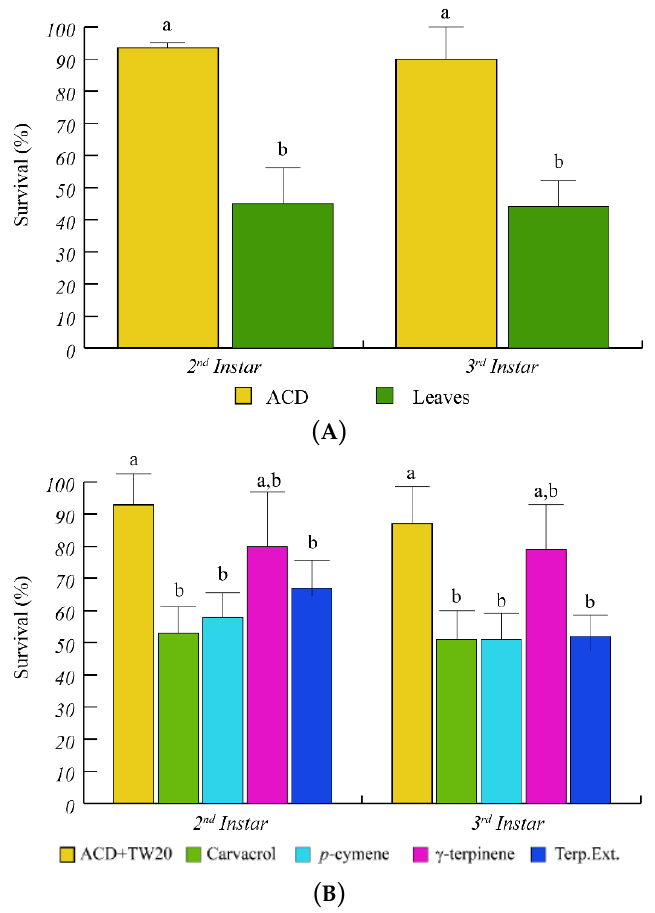
Figure 2. Percentage of S. littoralis survival upon feeding on O. vulgare leaves and terpenoids. ( A ) Comparison of S. littoralis survival upon feeding on artificial diet (ACD) or O. vulgare leaves. ( B ) Effect of terpenes extracted from O. vulgare leaves and of some O. vulgare monoterpenes on S. littoralis survival. ACD + Tween 20 was used as control. Bars indicate standard deviation. Different letters indicate significant ( p < 0.05) differences.